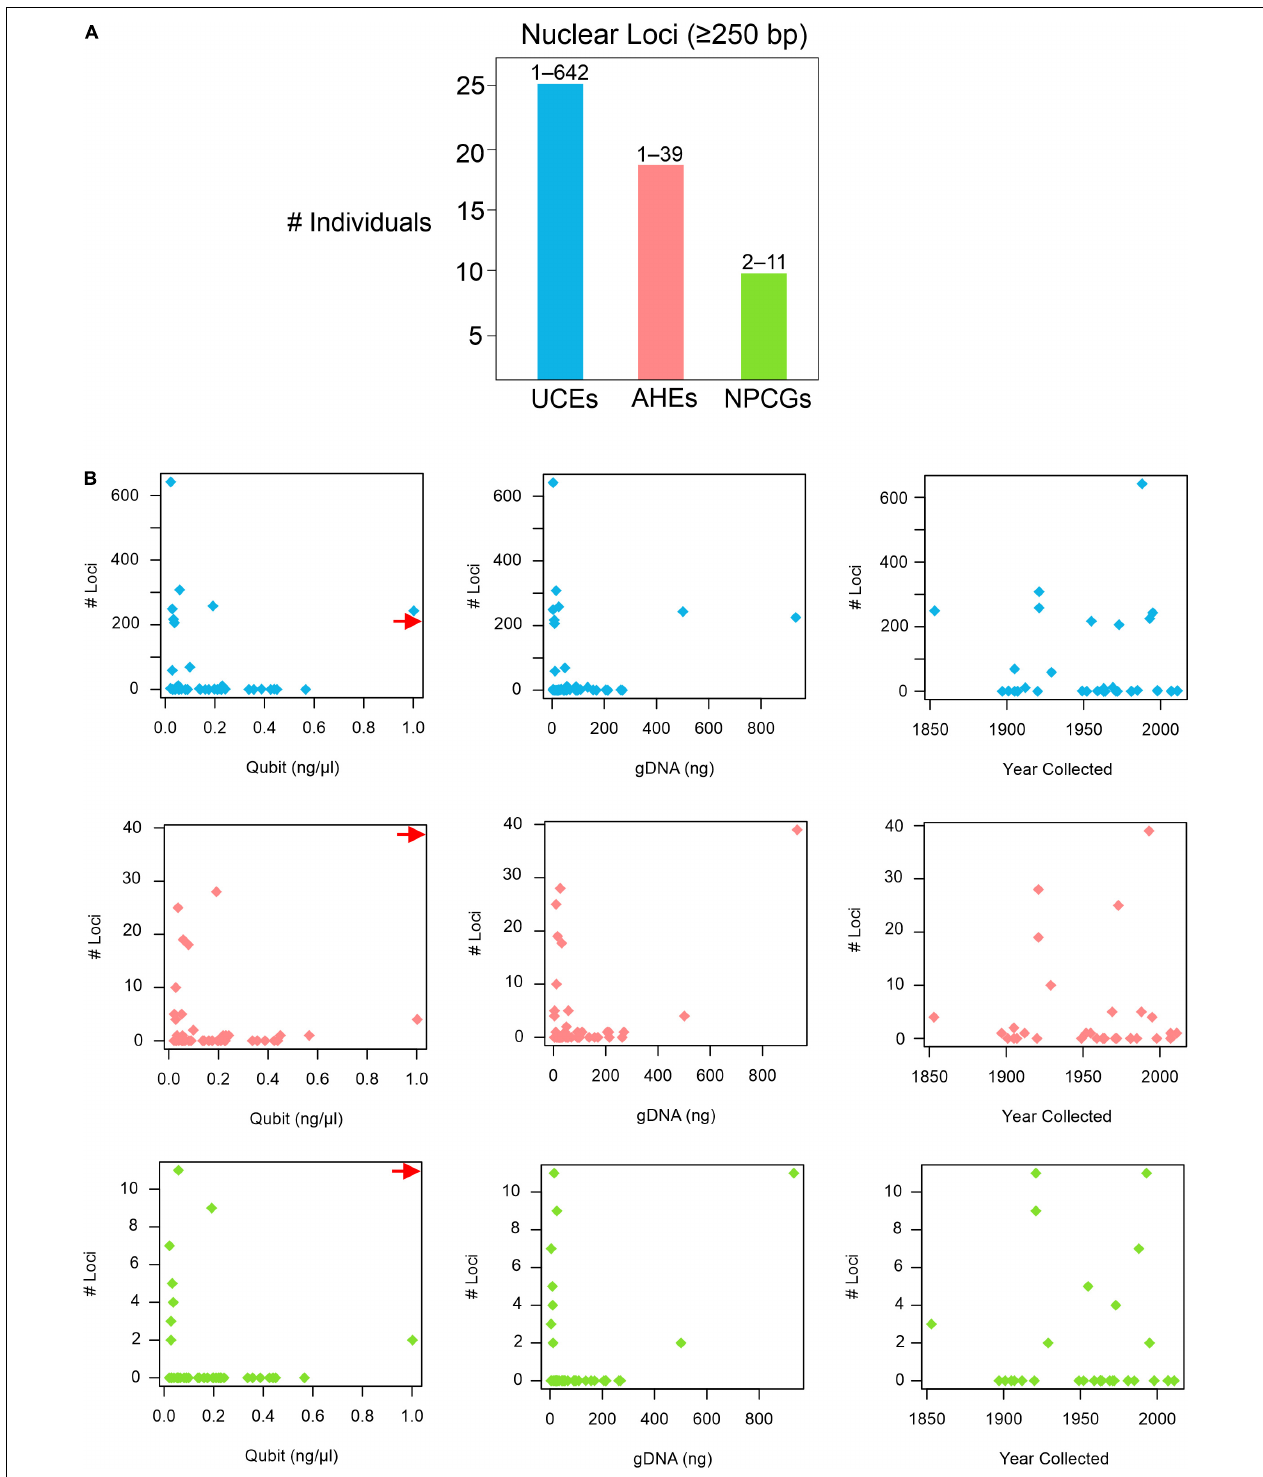
FIGURE 2 | Nuclear loci recovered from pseudoreference BLASTing. (A) Number of individuals that yielded UCEs, AHEs, and NPCGs ≥ 250 bp. Numbers above bars represent the range of number of loci recovered amongst all individuals. (B) Graphs showing the relationships of the number of UCEs (top), AHEs (middle), and NPCGs (bottom) and specimen age (year collected), DNA yield (Qubit), and total genomic DNA used for sequencing (gDNA). Red arrow shows data point for H. periops FMNH 251051 (Qubit = ∼ 6.0 ng/ µ l), arrow positioned along axis corresponding to respective Y -axis values. Complete list of all nuclear loci and lengths for each specimen is in Supplementary Table 4